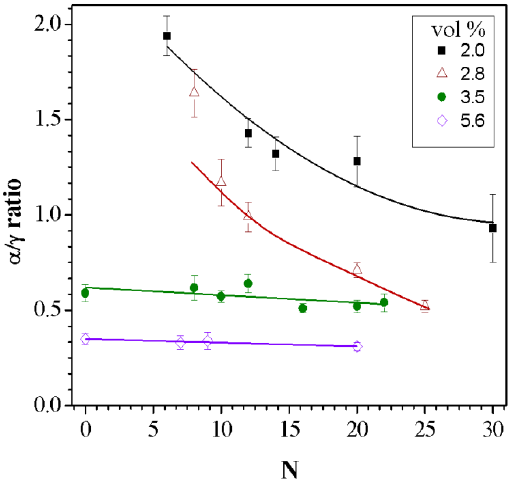
Figure 6. Variation of α / γ crystalline ratios with the processing parameter N for samples at the indicated NP compositions. The solid lines are drawn as a guideline for the